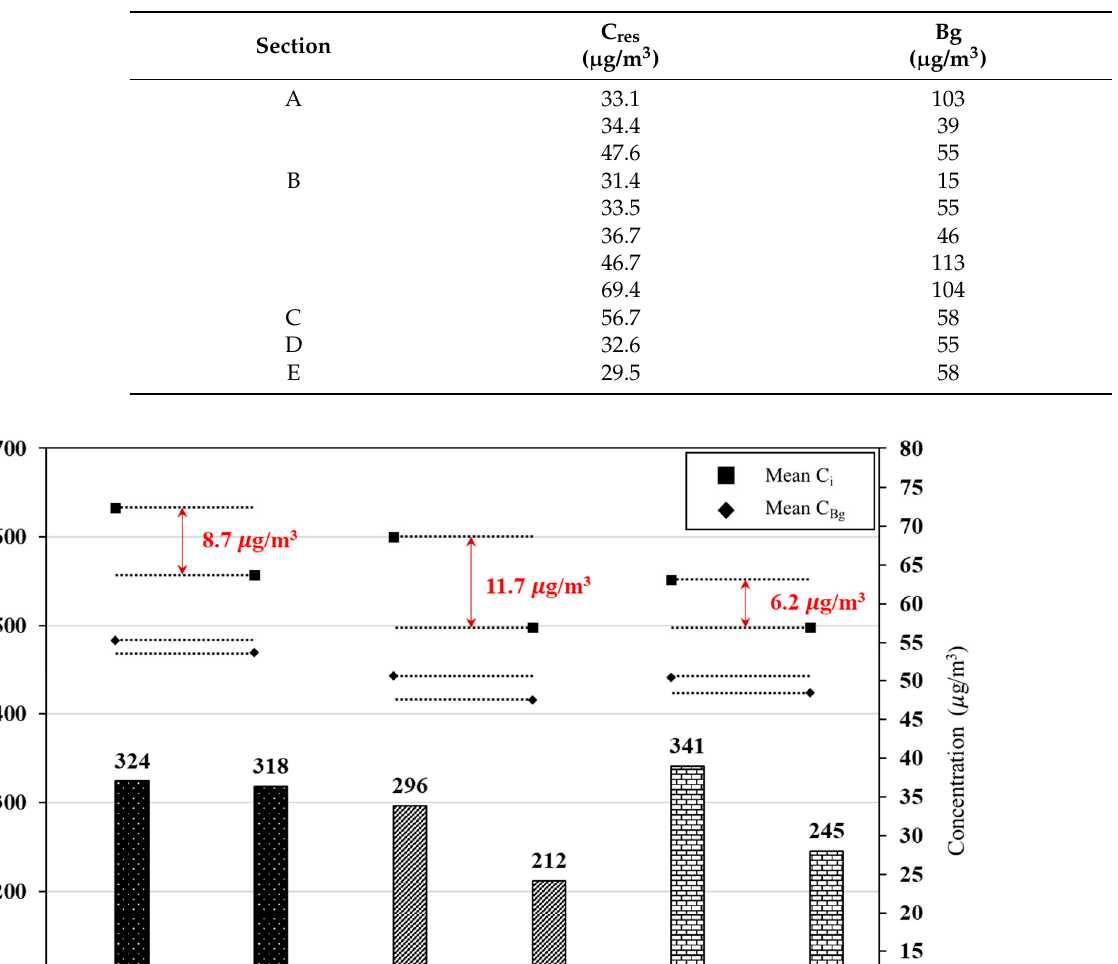
Table 4. Comparison of observed C res bad level concentrations by section and Bg concentration of the same time zone.